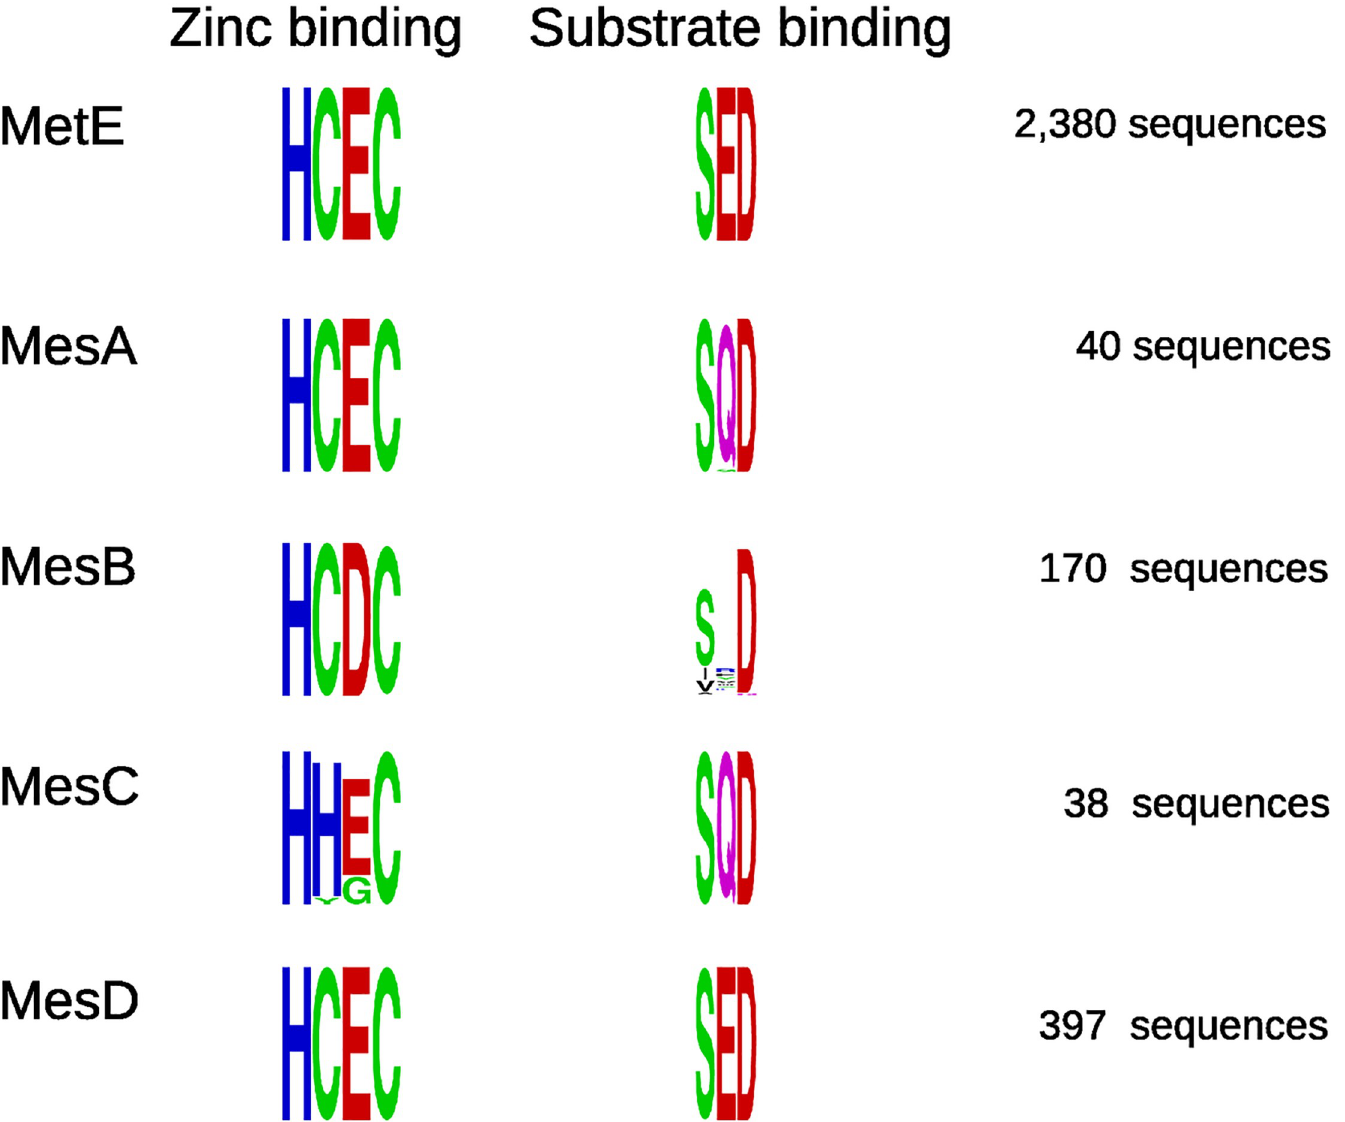
Fig 4. Functional residues of MetE and of core methionine synthases. We show sequence logos [33] for the zinc-coordinating and substrate-binding residues of each family of methionine synthases. The height of each position shows its conservation within the family, as measured by information content or bits. In MetE from E . coli , the zinc-coordinating residues are H641, C643, E665, and C726, and the substrate-binding residues are S433, E484, and D599.